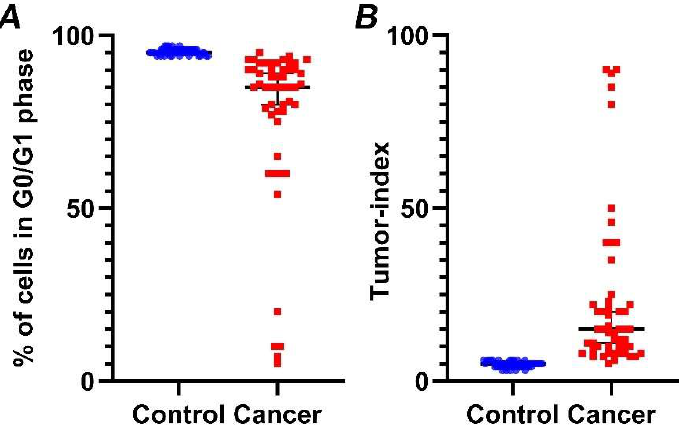
Figure 4. Percentage of cells in G0/G1 phase ( A ) and Tumor-index ( B ) in normal versus cancer samples, based on iFC. normal and cancer samples are presented as blue or red dots, respectively. Black horizontal lines represent median in each group. ( A ) Tumor samples exhibiting a significantly lower percentage in G0/G1 than normal bladder tissue. ( B ) Inversely, a significantly higher Tumor-index (the cumulative cell fraction in S and G2/M phases) is a hallmark of cancers cells.